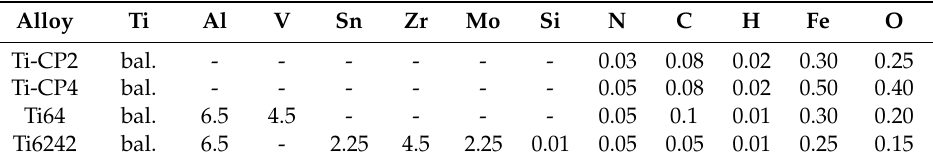
Table 1. Composition of titanium alloys (maximum values according to specification in wt. % [13] (bal: